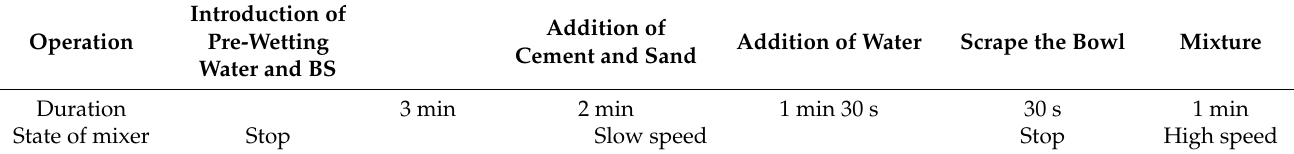
Table 3. Mixture